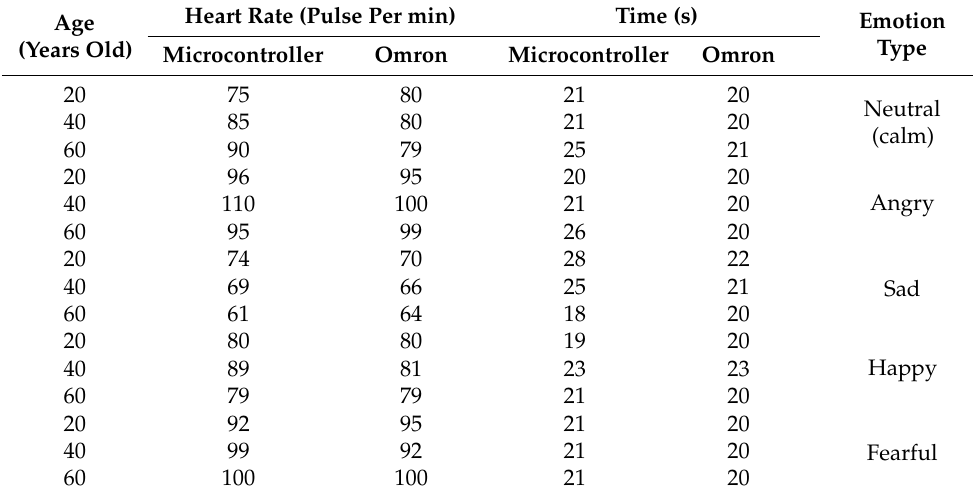
Table 2. Average Target Heart Rate Estimates.